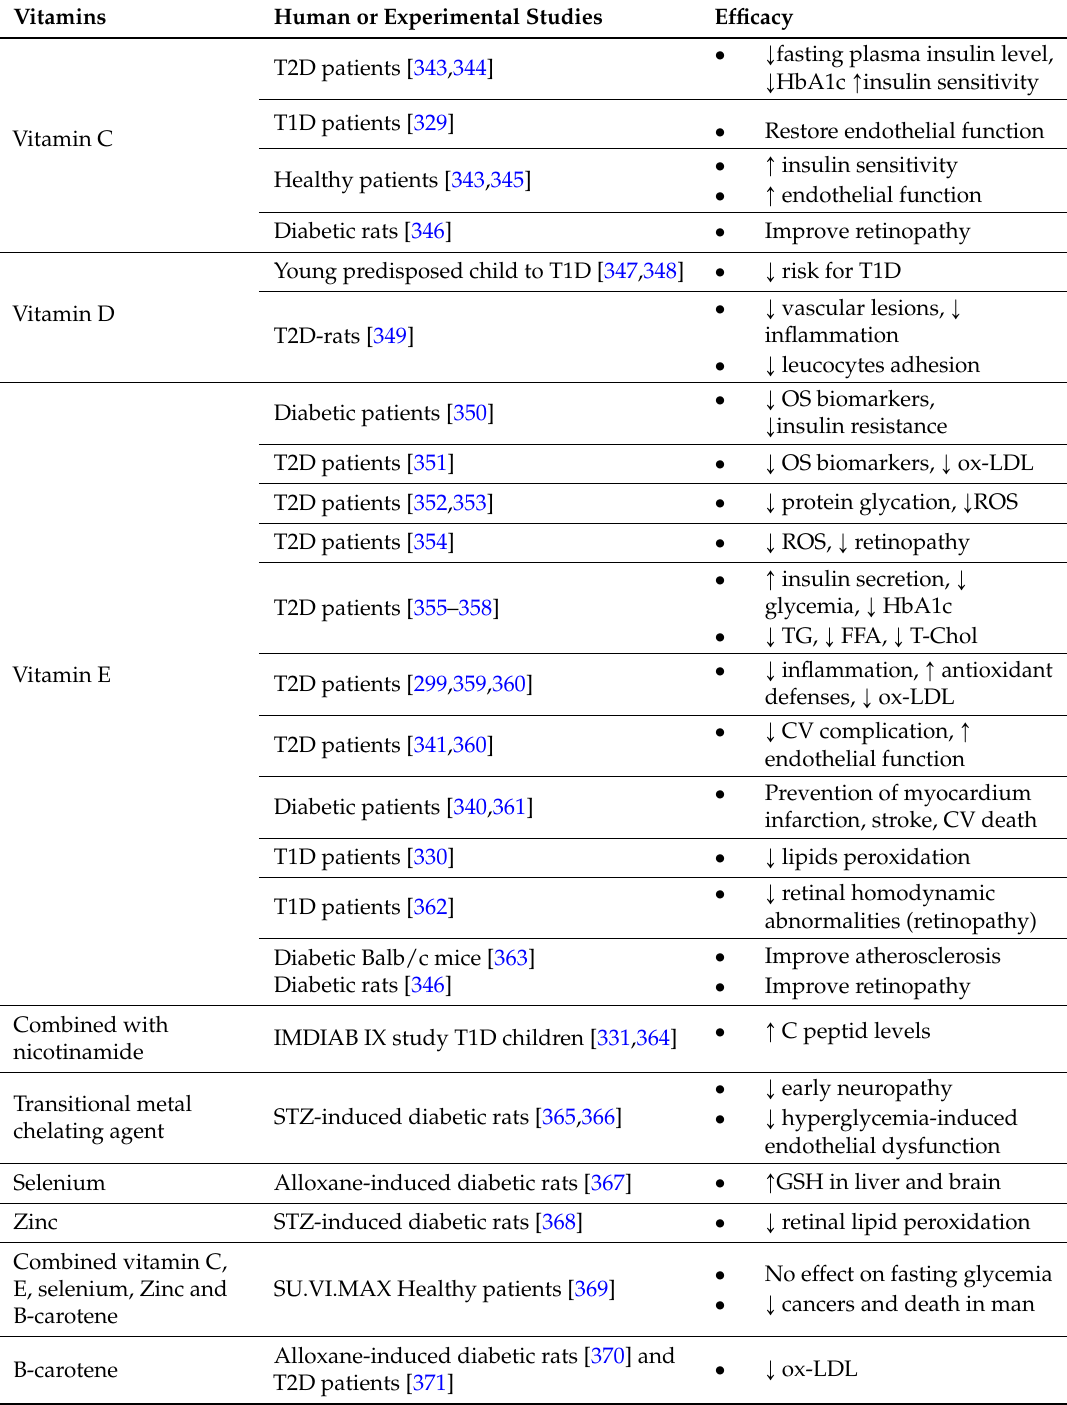
Table 4. Effect of vitamins and supplements in diabetes and